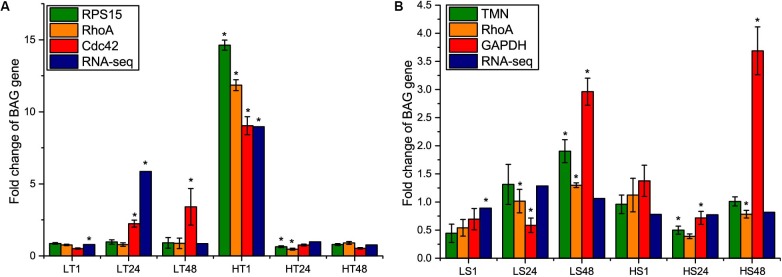
Comparison of relative expression levels of BAG gene normalized by the most stable reference gene (RPS15 and TMN) and the least stable gene (CDC42 and GAPDH) selected in temperature and salinity stress dataset separately, and the most stable reference gene (RhoA) selected in the combined dataset, with fold change values obtained from RNA-Seq results. (A) temperature stress, (B) salinity stress. LT, low temperature; HT, high temperature; LS, low salinity; HS, high salinity. The asterisks (∗) show the statistical difference (p < 0.05) between a treatment group and its corresponding control group.